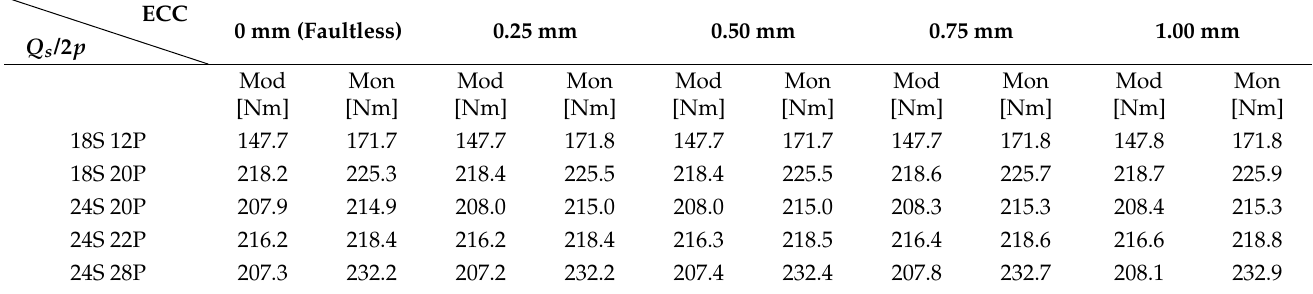
Table 19. Mean torque of different PMSM and MPMSM slot/pole combinations in the presence of